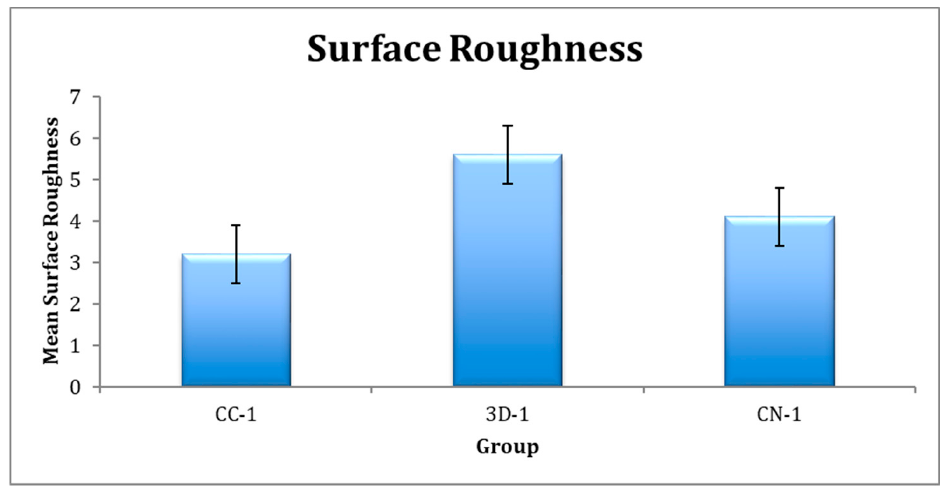
Figure 5. Mean surface micro-roughness of the specimens in the study groups. CC: CAD-CAM, CN: conventional, 3D: 3D printing.